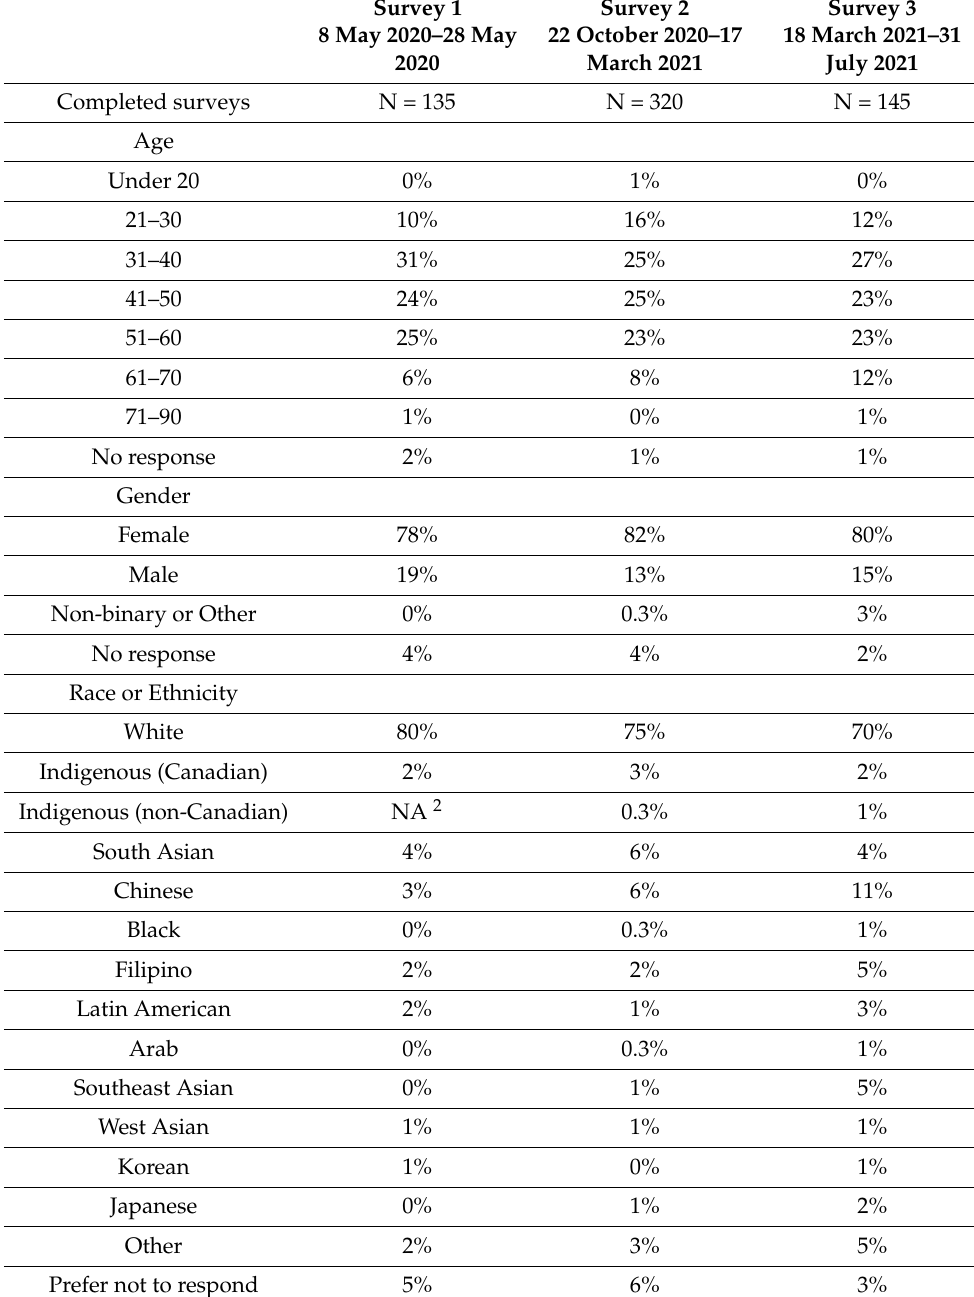
Table 1. Demographics of survey participants 1